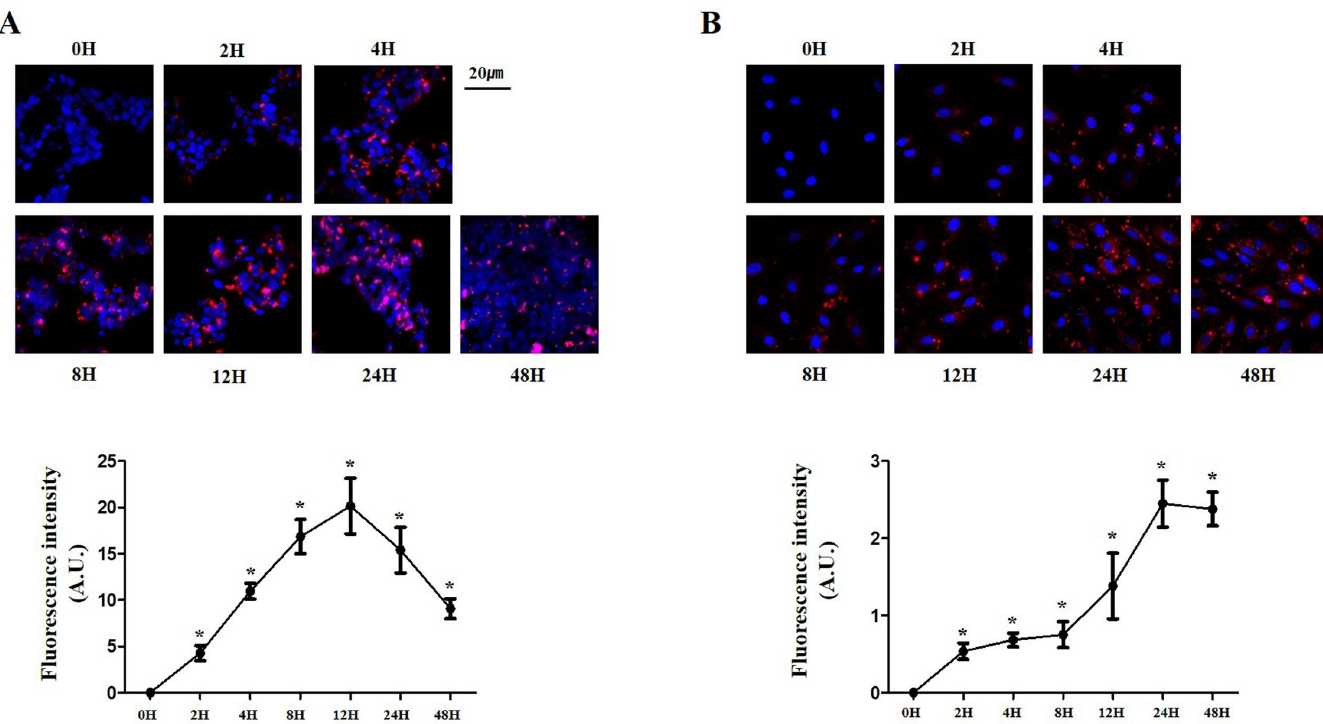
Fig 3. Delivery efficiency of exosomes with CaCl 2 in a time-dependent manner. (A) and (B) Delivery efficiency of exosomes labeled with PKH26 (red) at different time exposures to CaCl 2 -treated exosomes in HEK 293 (A) and H9C2 (B) cells. Fluorescent microscopic images (upper panels) and fluorescence intensity (lower panels). � P < 0.01.